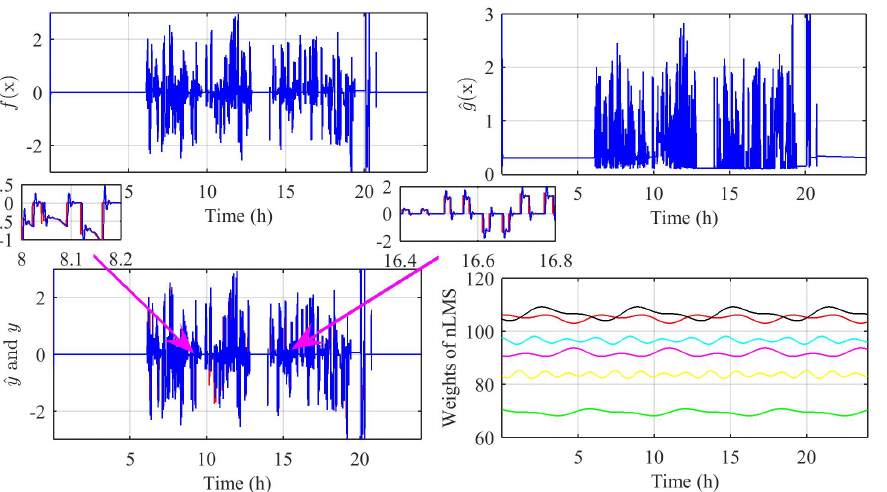
Figure 15. ( a ) Estimated function (cid:98) f ( x ) ; ( b ) estimated function (cid:98) g ( x ) ; ( c ) identification of the SOFC with fully recurrent NeuroFuzzy Laguerre wavelet control (FRNF-Lag-WC); ( d ) weights of n